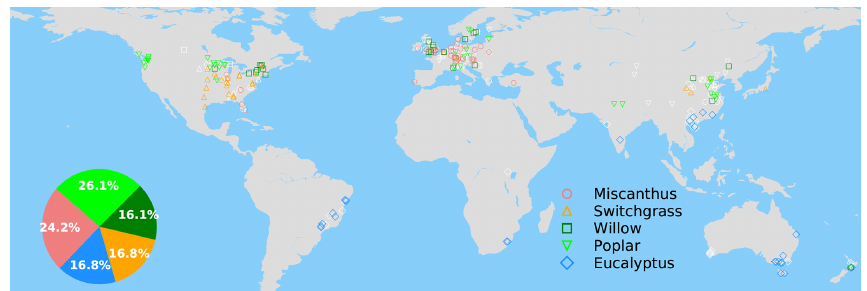
Figure 1. Map of grid cells with yield observations in the global yield dataset. The colored and white markers indicate the selected (blue dots in Fig. S4a) and masked (gray dots in Fig. S4b) grid cells, respectively, based on a bias threshold of 1 σ for the RF modeling of these yields. The inset pie plot shows the percentages of each bioenergy crop type in the selected grid cells (colored markers) for model